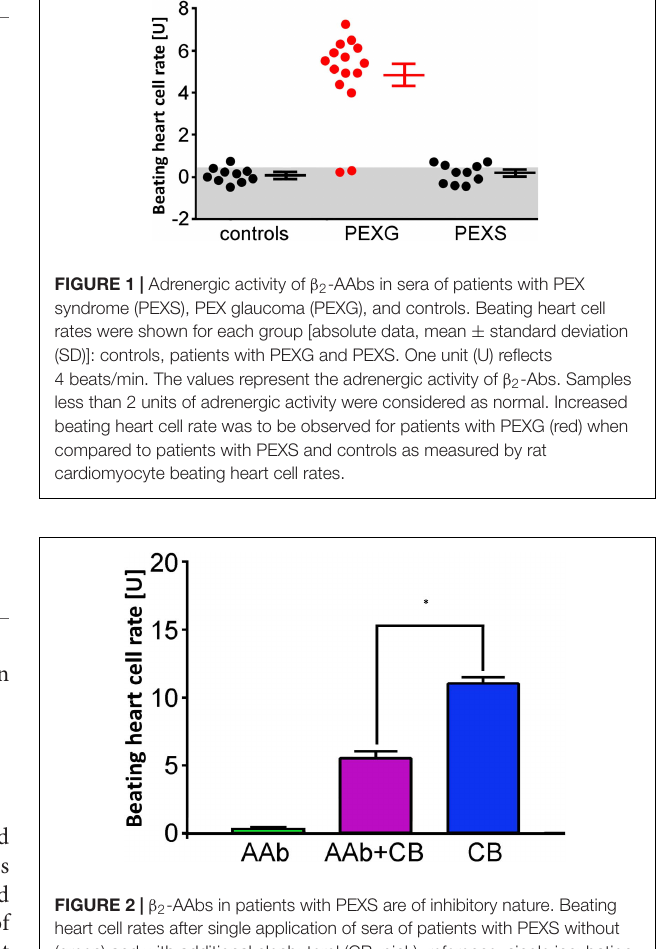
TABLE 1 | List of abbreviations.